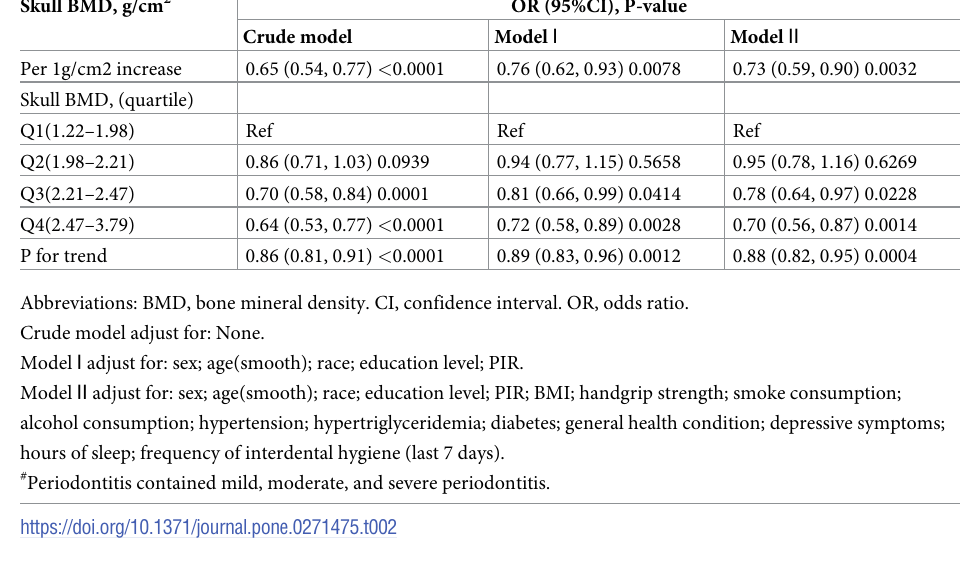
Table 2. Association between skull BMD with periodontitis in different models.